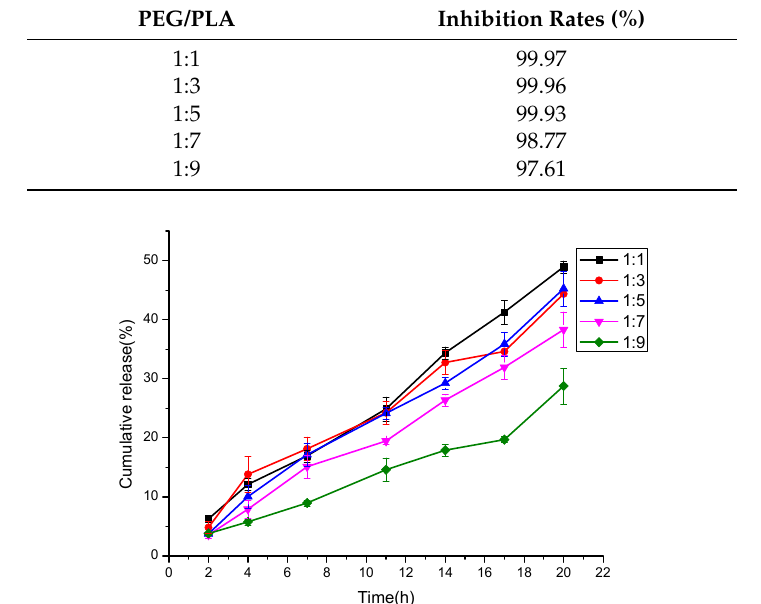
Figure 8. Initial burst release of Cur from PLA/PEG/Cur CNFMs with different weight ratios (PEG:PLA).